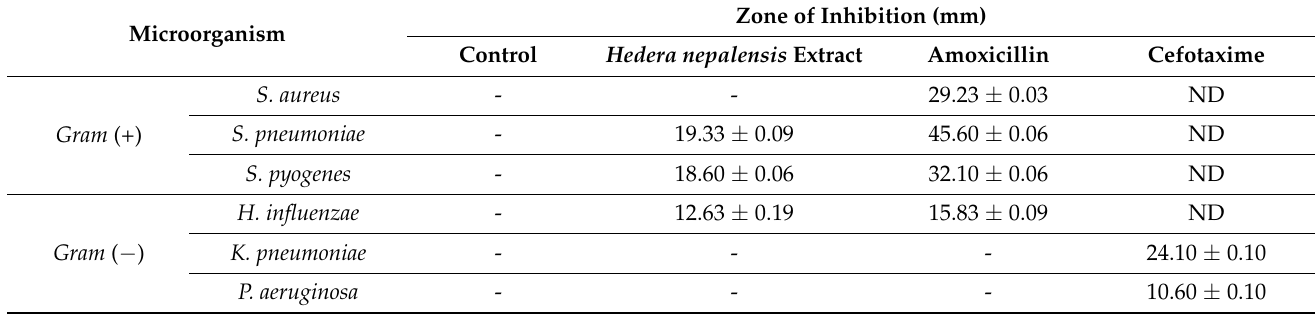
Table 4. Antibacterial activity of the extracts from H. nepalensis leaves on several strains of bacteria related to respiratory